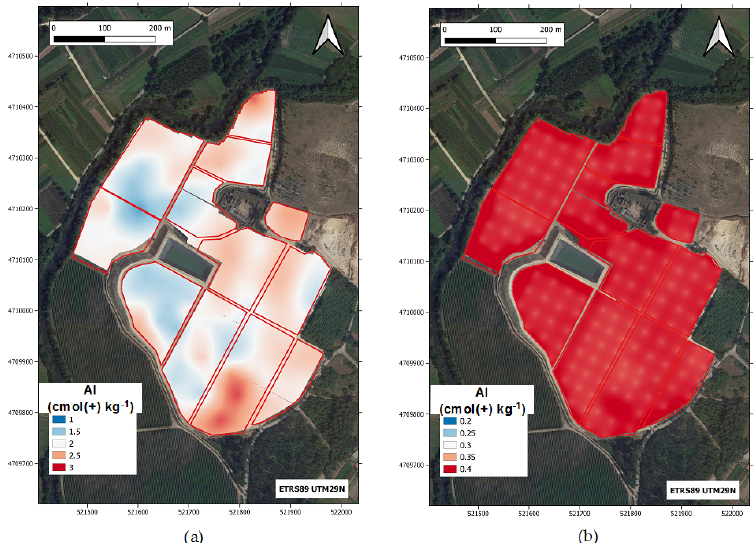
Figure 10. Estimation ( a ) and error ( b ) maps of aluminum content over the experimental vineyard generated by ordinary kriging. generated by ordinary